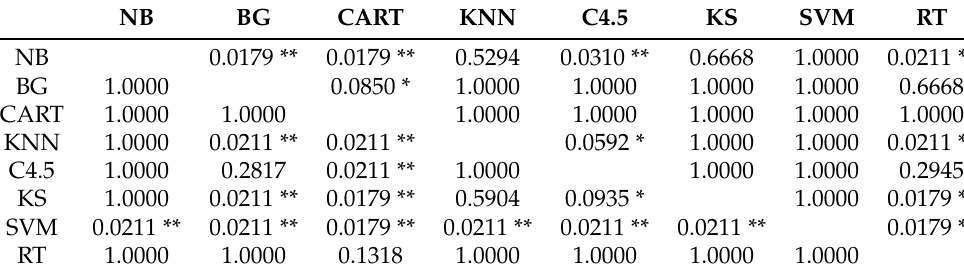
Table 15. Pairwise WSR test for F1-Measure of